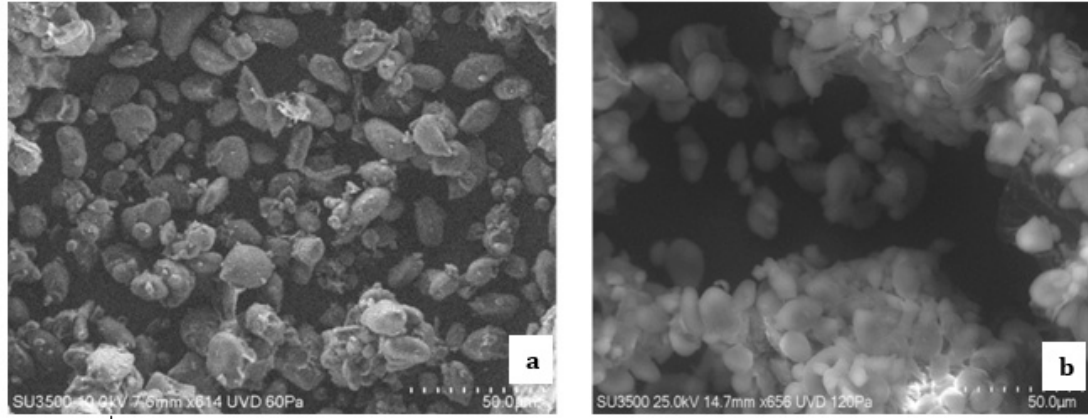
Figure 1. Micrographs obtained by scanning electron microscopy (SEM) for teosinte flour ( a ) and teosinte starch ( b ).